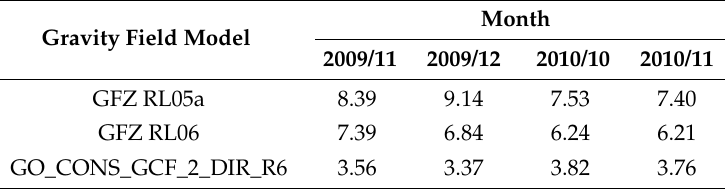
Table 4. RMS of orbit fits [cm] for the time-variable GFZ RL05a and RL06 gravity field models and (only for reference) for the static model GO_CONS_GCF_2_DIR_R6. RMS values are based on 3D residuals and represent mean values of the 30 individual arcs within a particular